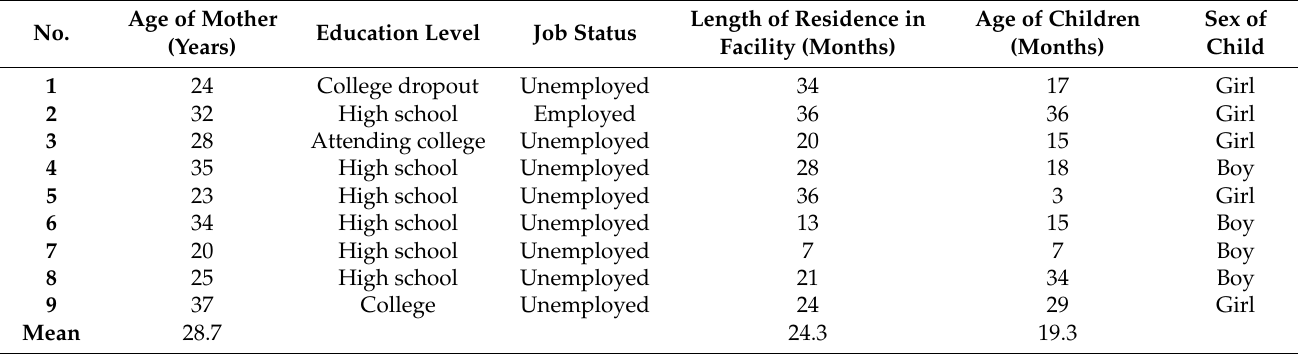
Table 2. General characteristics of